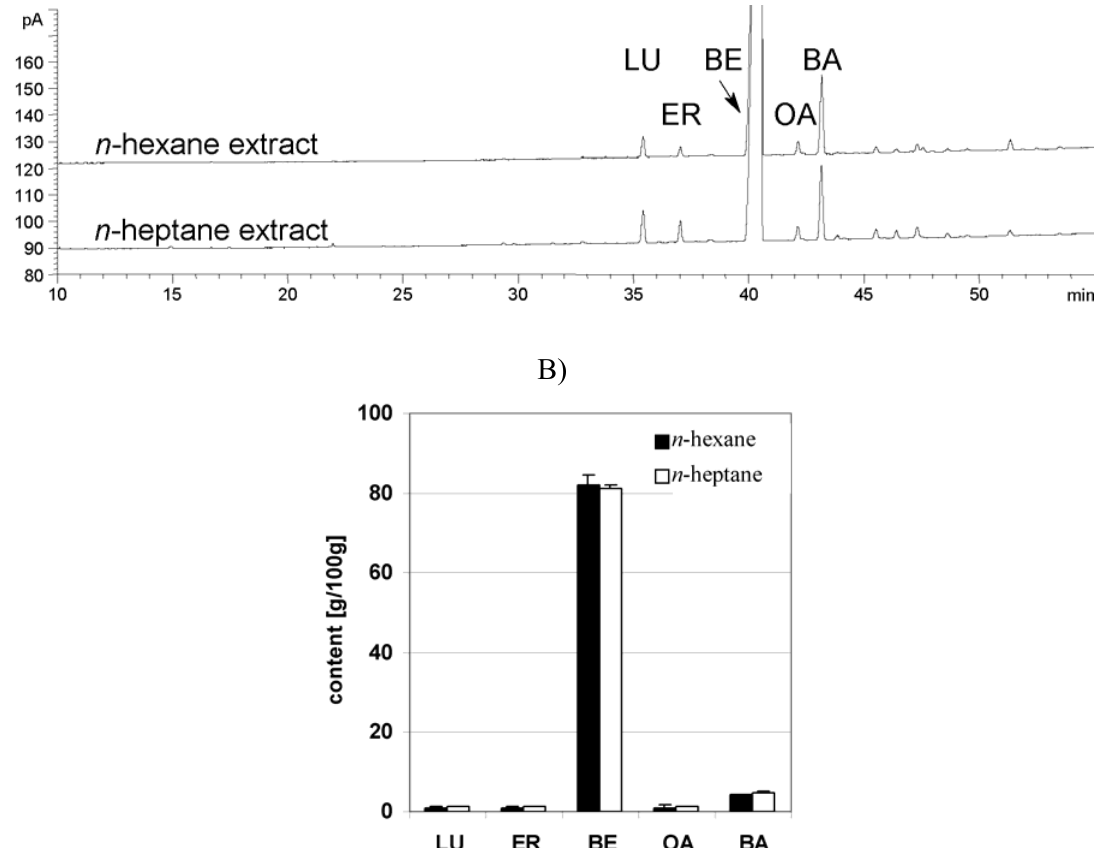
Figure 1 . Qualitative and quantitative comparison of triterpene distribution in TE depending on extraction solvent (GC-FID). A) Chromatogram of n- hexane- and n- heptane extract. B) Quantitative comparison of n- hexane- and n- heptane extract. Standard deviation is displayed as error bars of n- hexane (4 batches) and n- heptane extracts (6 batches); error bars: SD.